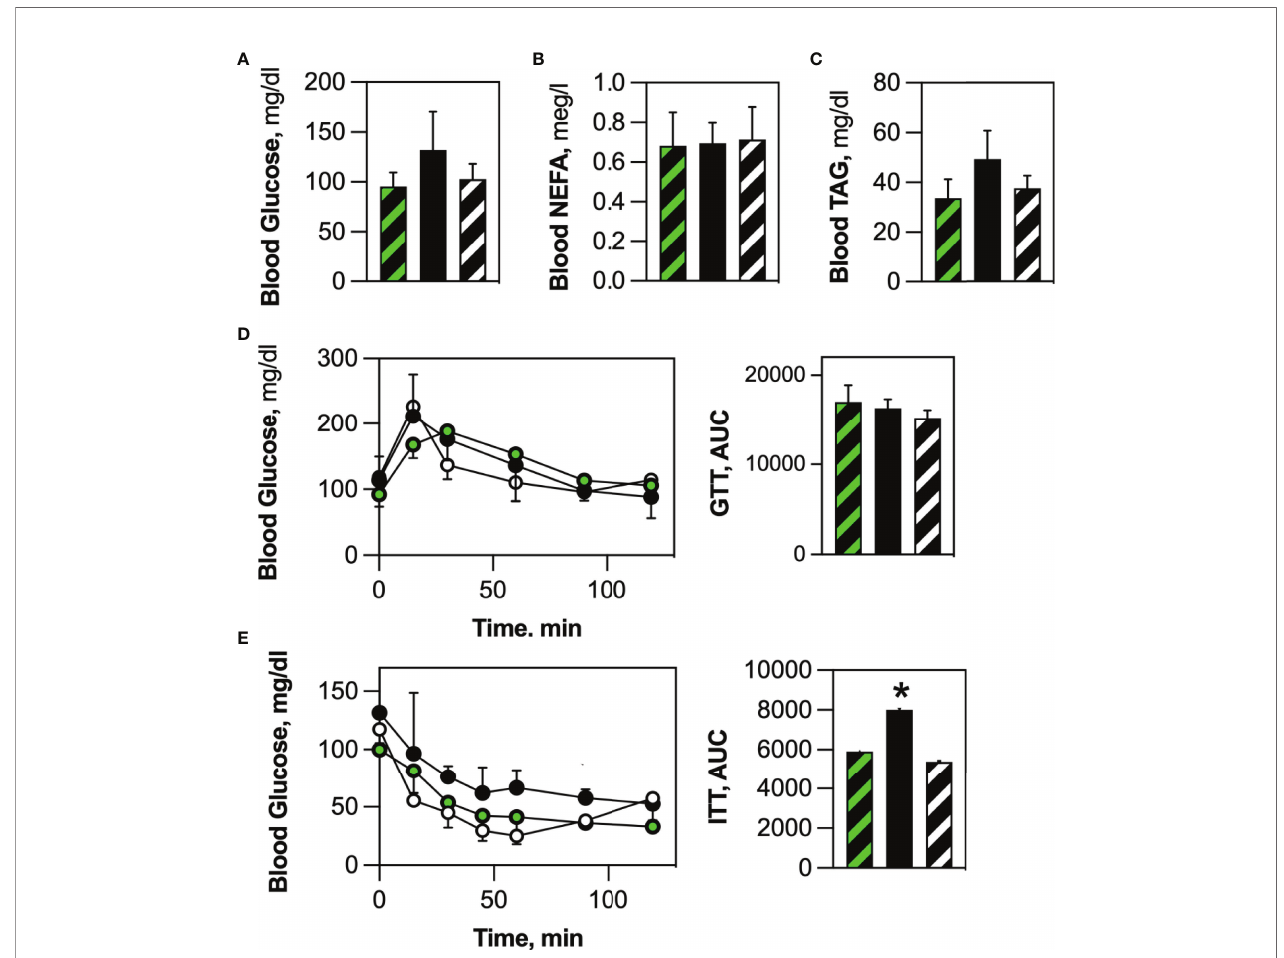
FIGURE 7 | HSCDA ablation elicited insulin resistance. No differences were noted in (A) circulating glucose, (B) non-esteri fi ed fatty acid (NEFA) or (C) triacylglycerol serum levels between fasted transplant-naïve (black/white crosshatch bars), Competent (black/green crosshatch bars) and Ablated (solid black bars) cohorts. (D) Likewise, all cohorts (transplant-naïve = black/white circles, Competent=black green circles, Ablated=solid black circles) exhibited the same time course of blood glucose disposal when challenged with an oral glucose bolus. (E) Insulin-stimulated glucose disposal was signi fi cantly inhibited in Ablated mice. (n=8 per cohort, *indicates p ≤ 0.05) (AUC = Area Under the